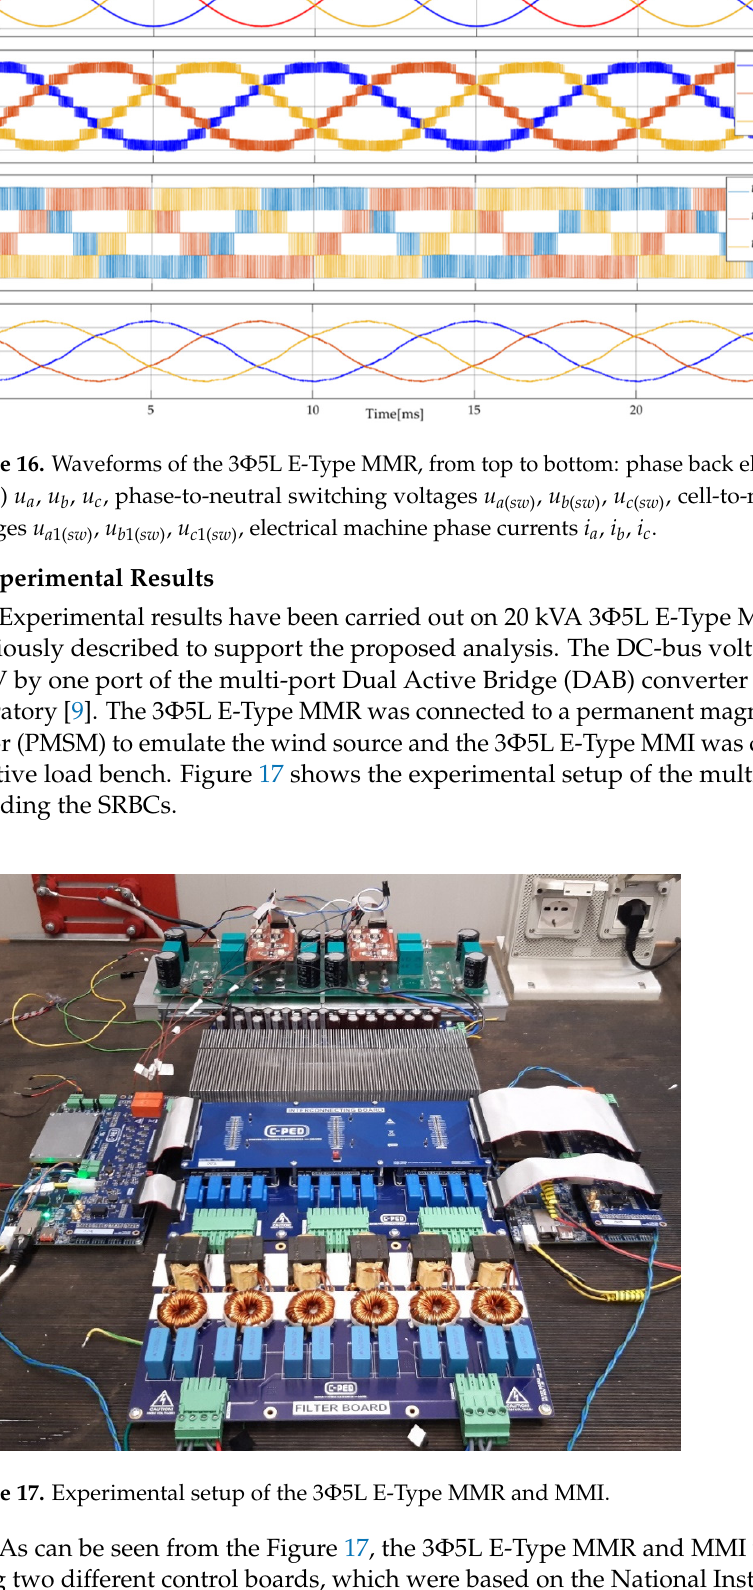
Figure 17. Experimental setup of the 3 Φ 5L E-Type MMR and MMI.